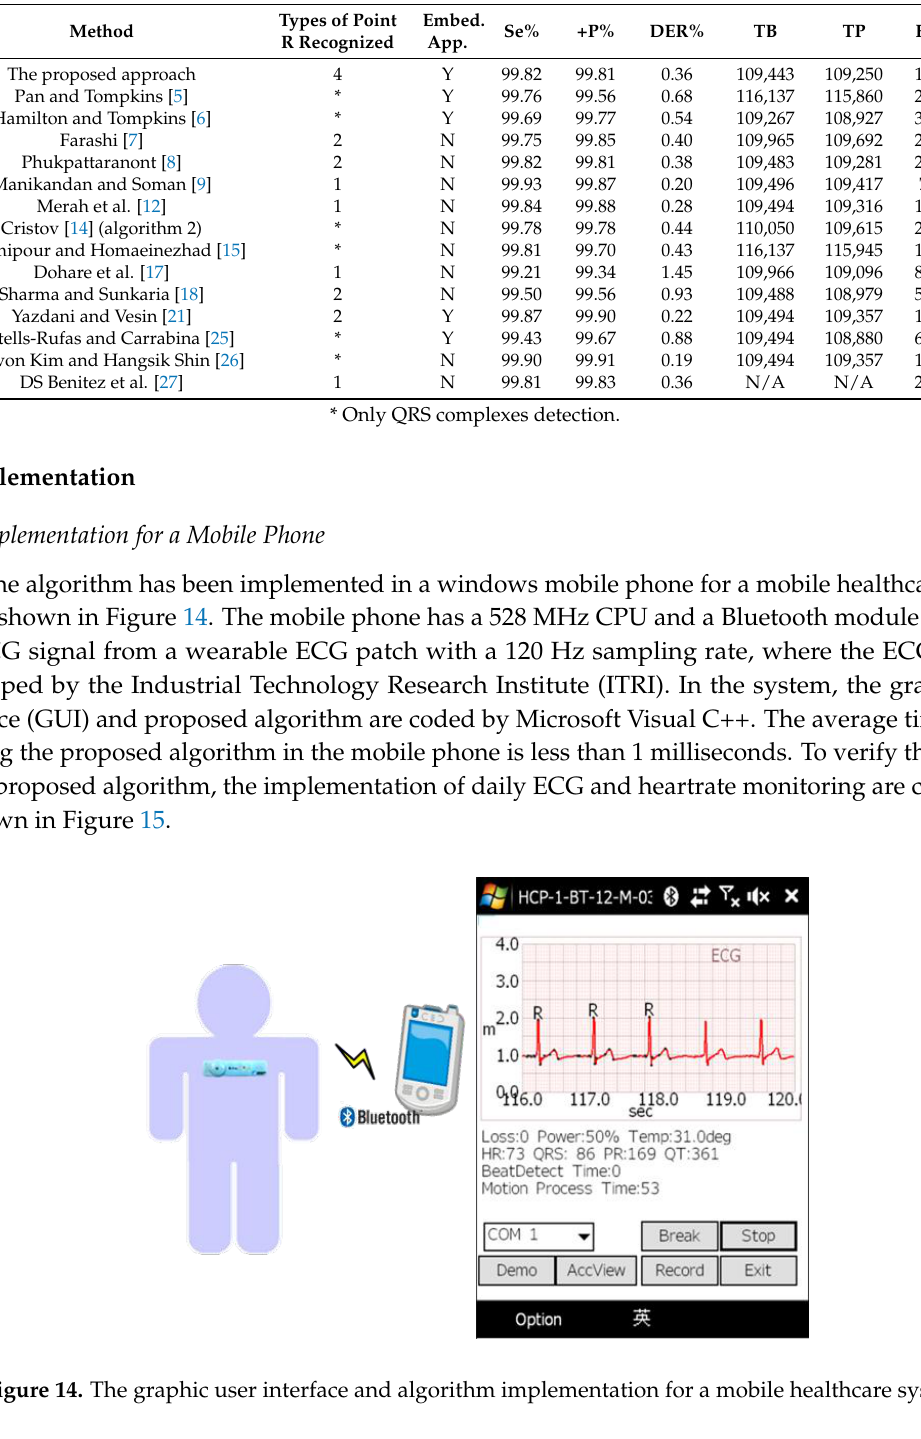
Table 3. Comparison of this study with other studies using the MIT-BIH arrhythmia database.